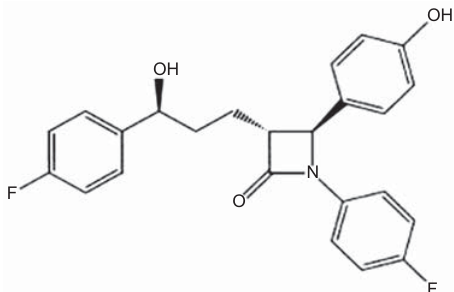
Figure 1 Chemical structure of